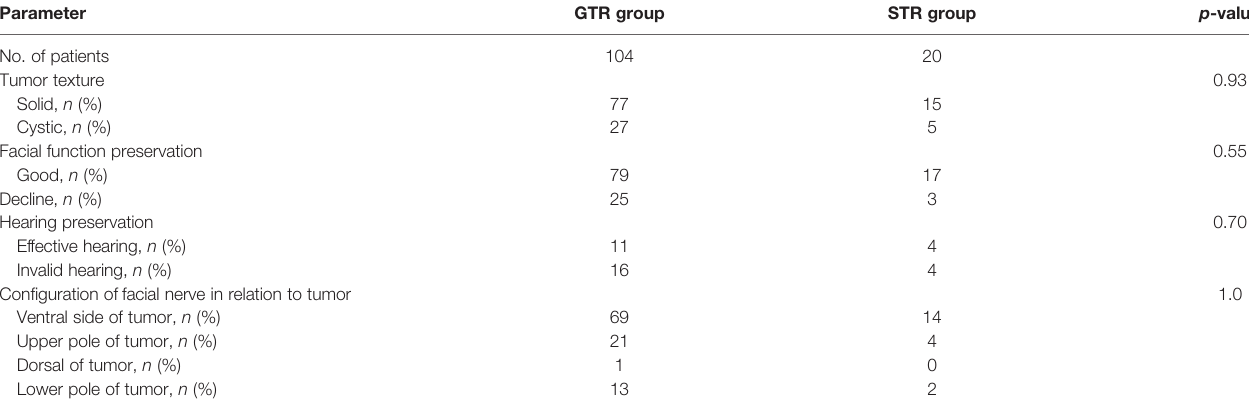
TABLE 2 | Analysis of categorical variables between the gross total resection (GTR) group and subtotal resection (STR) group. Parameter